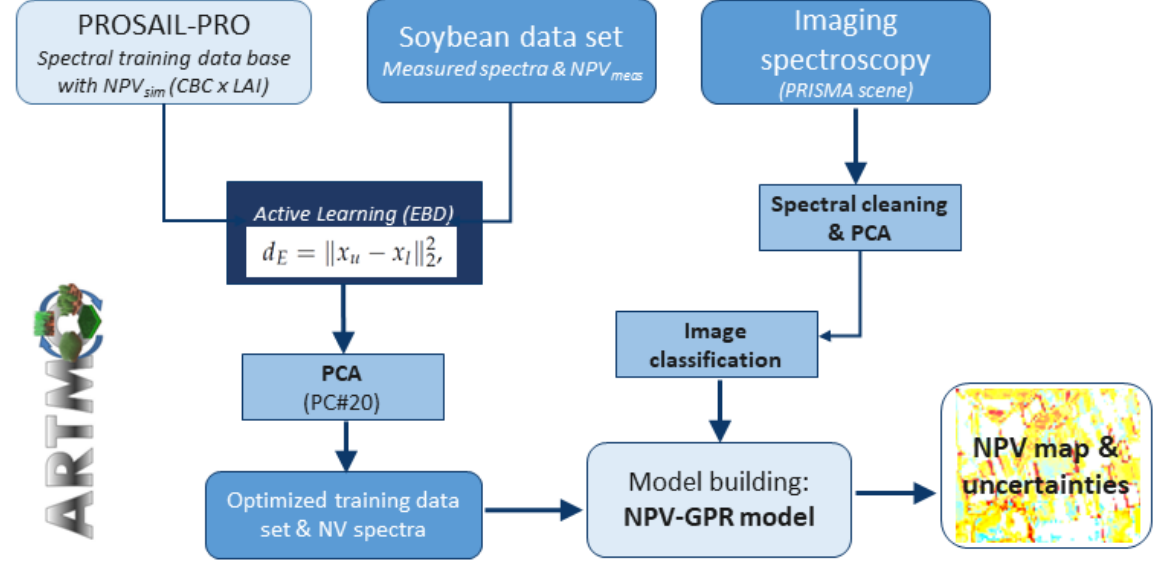
Figure 1. Schematic workflow for NPV